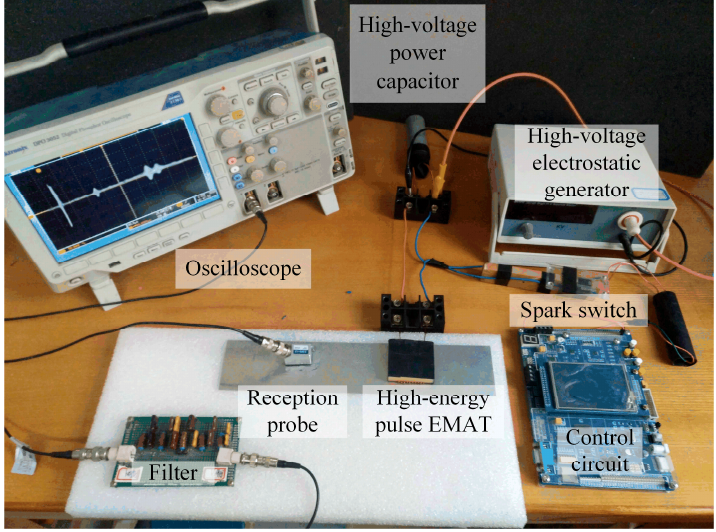
Figure 11. Experimental system of high-energy pulse EMAT.